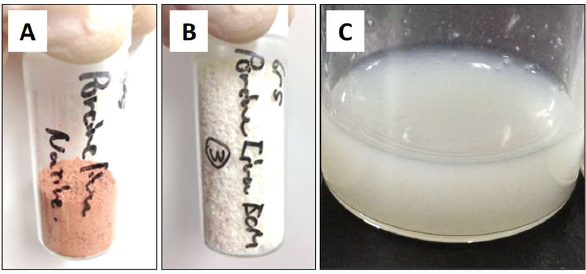
Figure 3. ( A ) Appearance of natural liver powder, ( B ) decellularized liver powder, and ( C ) L-ECM.